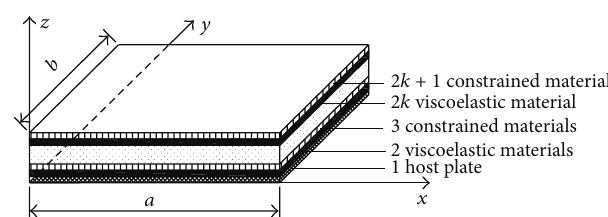
Figure 1: Multilayered constrained damping plate.